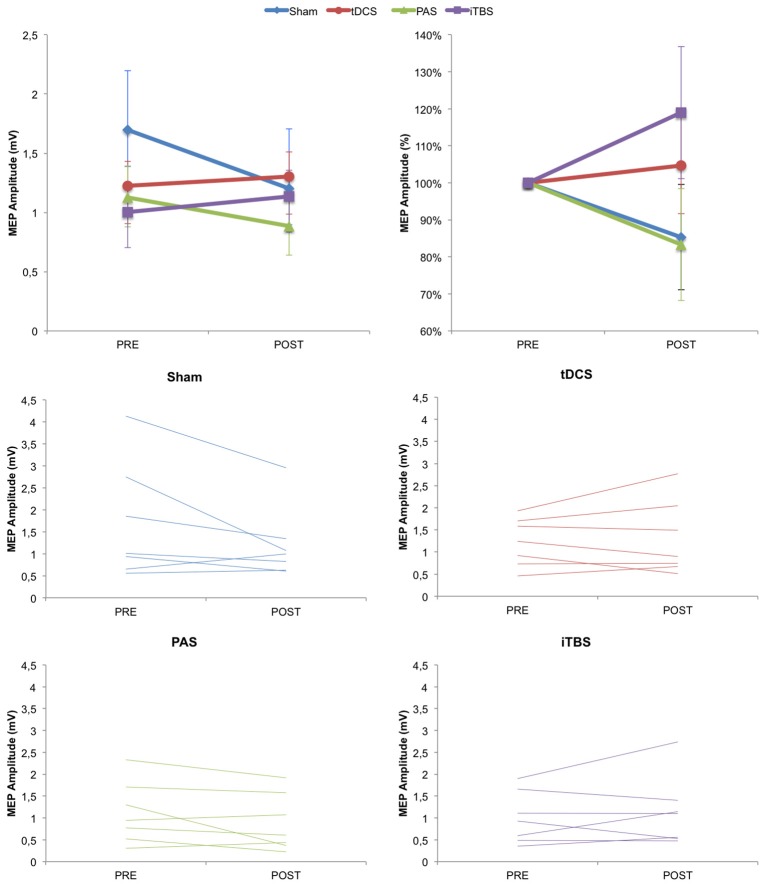
Change in cortical excitability as measured by MEP amplitude over time. (Top) Group averaged data for absolute MEP values and normalized MEP values. (Bottom) Plots for Sham, tDCS, PAS25, and iTBS groups showing individual subject data. Error bars represent standard error.